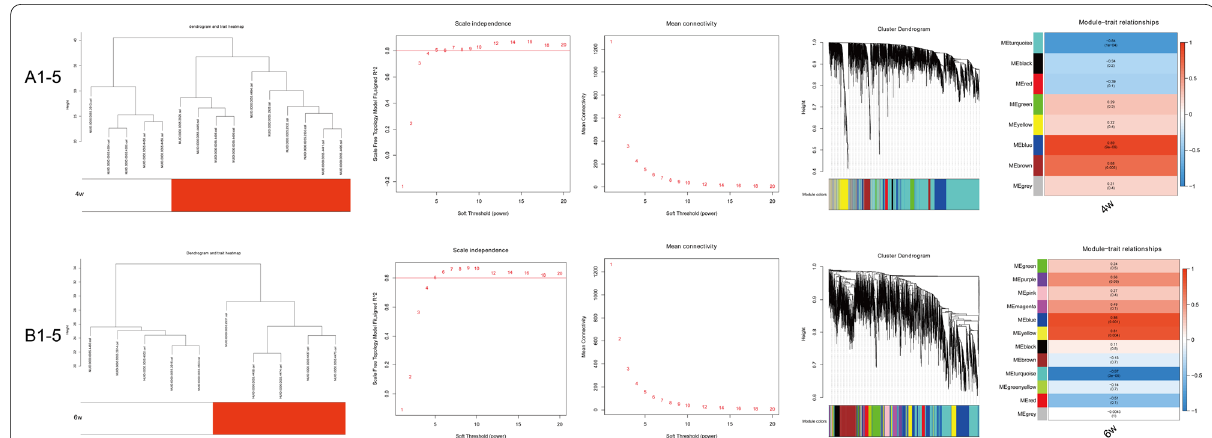
Fig. 2 WGCNA for genes associated with AIC using E-MTAB-1168. A1–5 for 4-week doxorubicin treatment, B1–5 for 6-week doxorubicin treatment. A1–5 1–5 in order: Clustering dendrogram of rat heart tissue samples; analysis of the scale-free fit index for various soft-thresholding powers; analysis of the mean connectivity for various soft-thresholding powers; dendrogram of all differentially expressed genes clustered based on a dissimilarity measure (1-TOM); heatmap of the correlation between module eigengenes and doxorubicin treatment